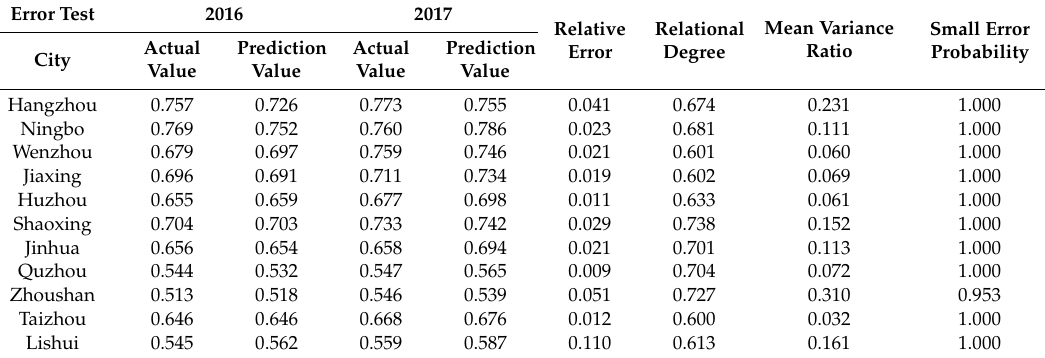
Table 4. GM (1,1) error test based on CDI value in 2016–2017.